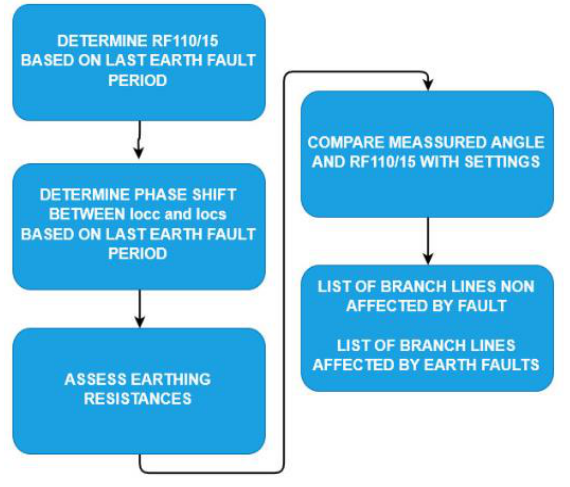
Figure 21. General fault location algorithm.